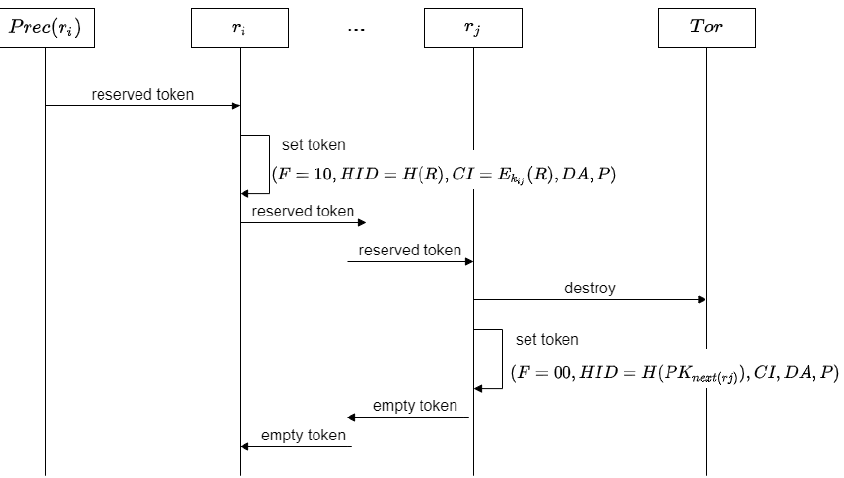
Figure 6. Process of emptying the tokens and destroying the Tor circuit.